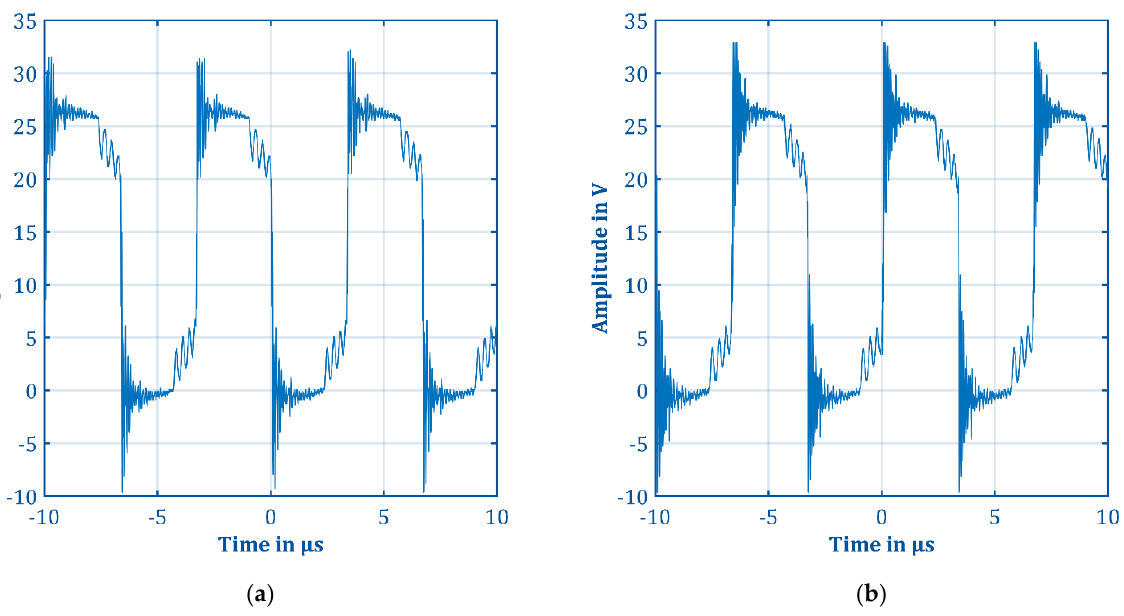
Figure A2. ( a ) Left input of the voltage rectification and regulation electronic in blue after the transformer with the coupling capacitor referenced to ground, at 150 kHz with the Circular PCB transformer; all other transformers look almost identical. ( b ) Shows the other input at the same time also referenced to ground.